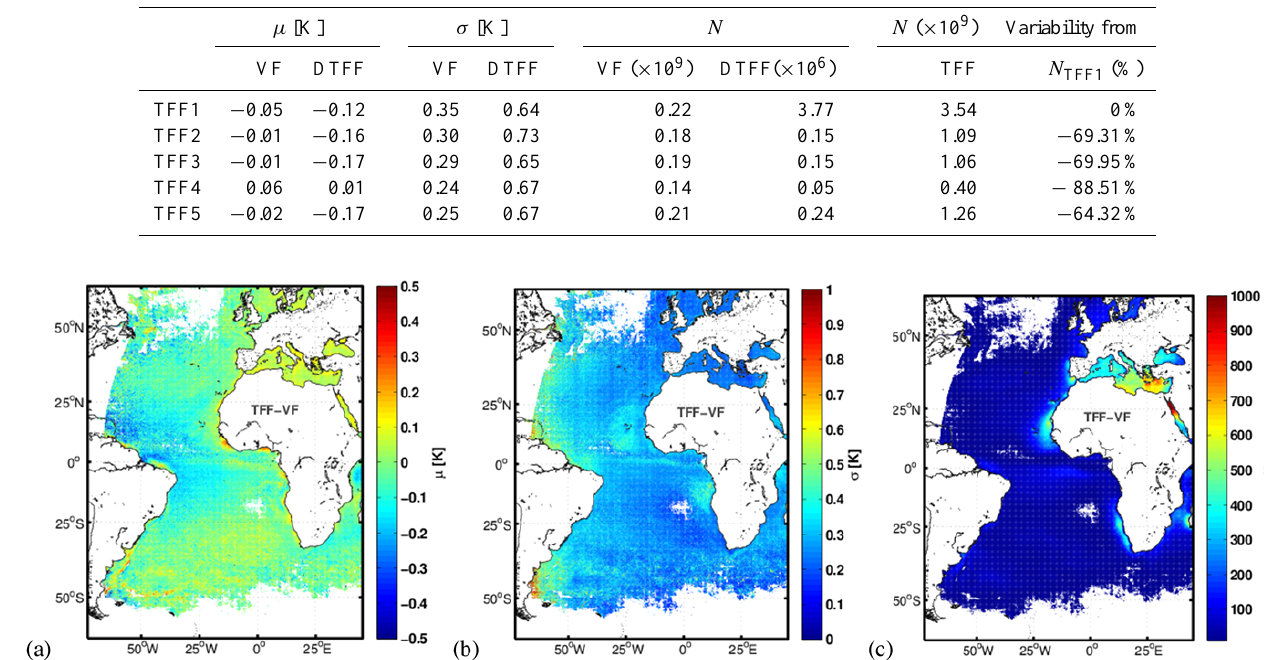
Figure 3. Mean bias µ (a) , standard deviation σ (b) and number of match-ups N (c) , for the